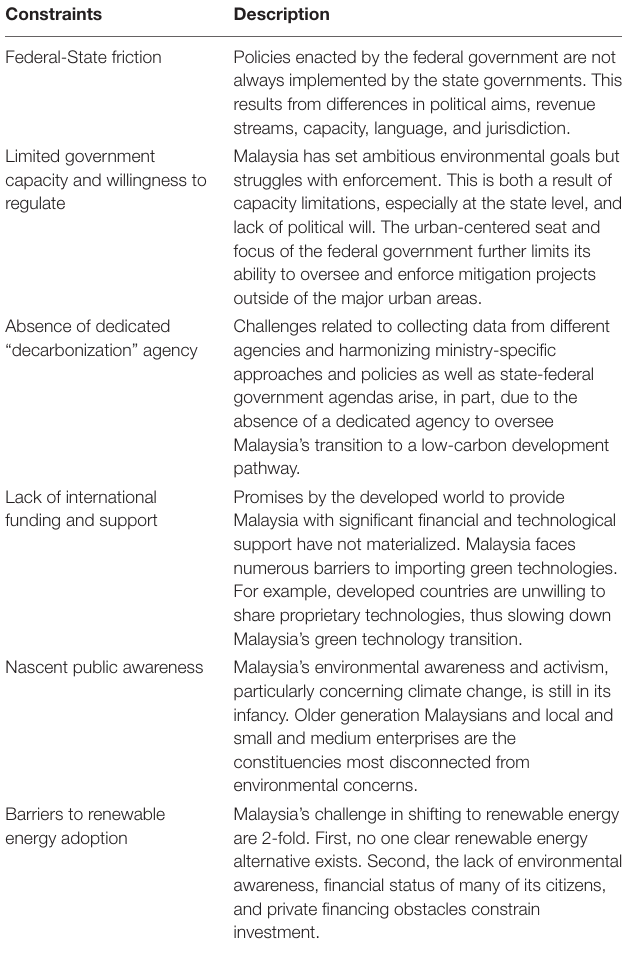
TABLE 3 | Systemic Constraints on Malaysia’s efforts to decarbonize.